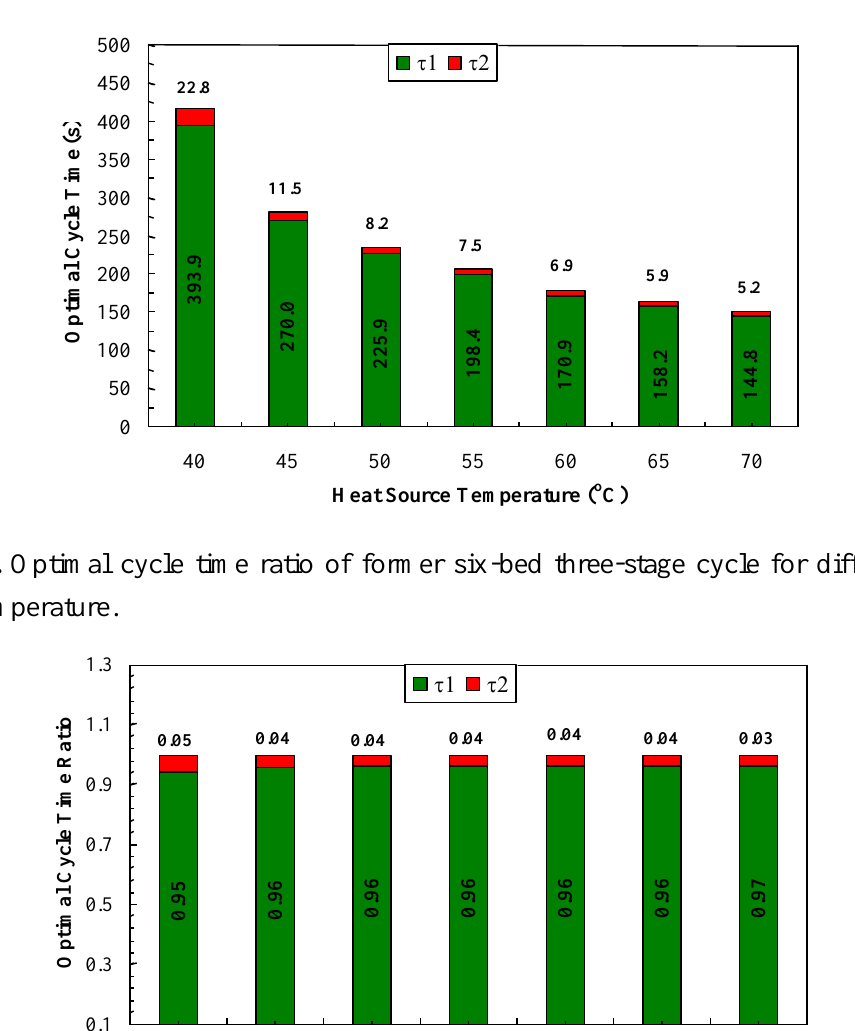
Figure 5. Optimal cycle time of former six-bed three-stage cycle for different heat source temperature.